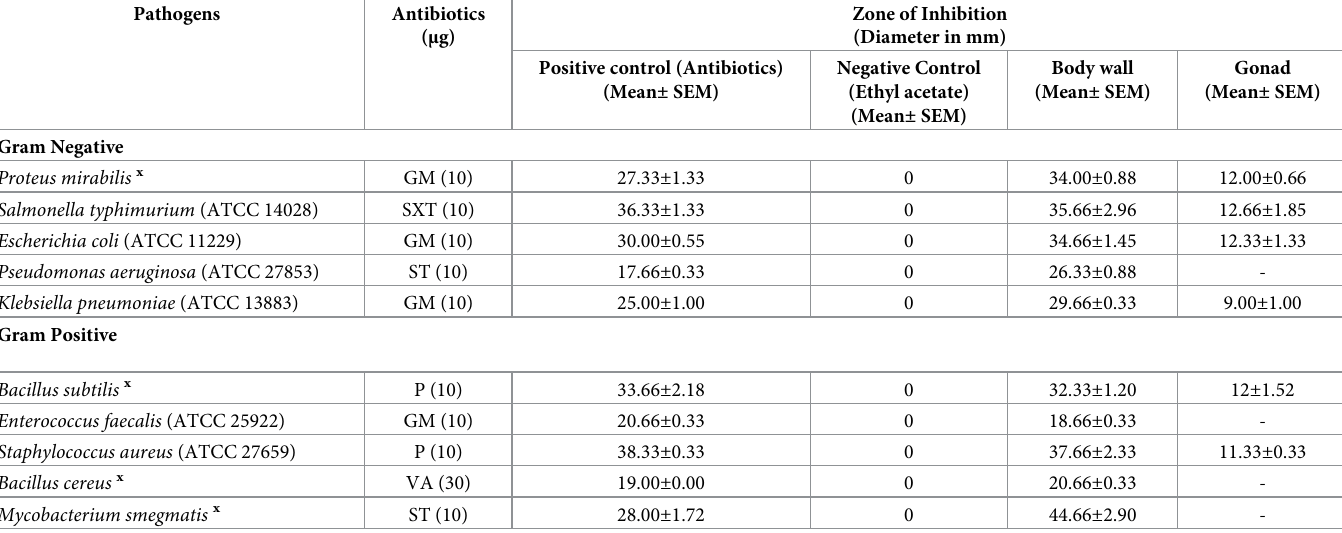
Table 1. Antibacterial activity demonstrated by the ethyl acetate extracts of Luidia clathrata tissues (body wall and gonad) on selective pathogenic bacteria achieved by the disk diffusion method. Pathogens